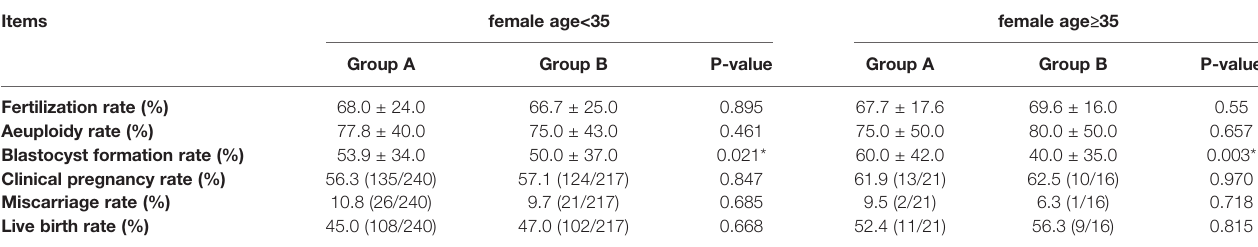
TABLE 2 | Blastocyst conditions and pregnancy outcomes between male carriers and female carriers in young and advanced maternal age.